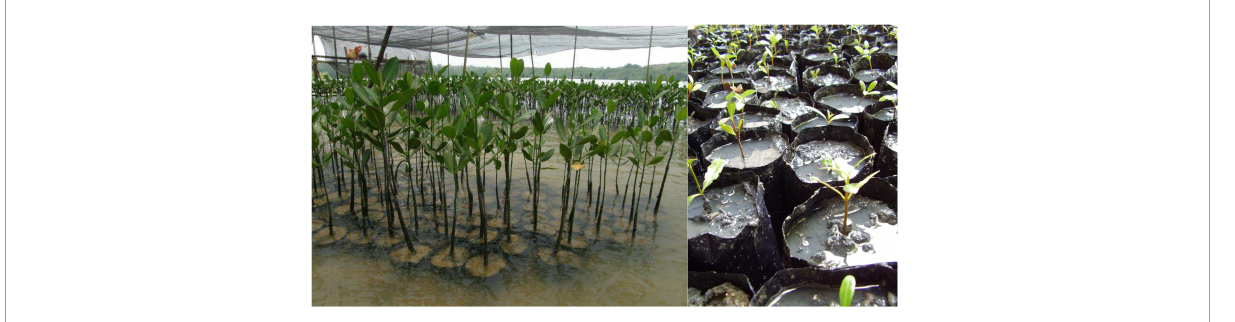
FIGURE2 Ecologically sensitive mangrove plant acclimation strategy. The eco-physiological hardening of Rhizophora stylosa (left) and Avicennia officinalis (right) saplings (inoculated with “old” mud taken from suitable reference sites) by using natural tidal inundation for 1–2 months (Left: 2011, Singapore; Right: 2006, Sri Lanka) (photograph credits: Left: Chua Jit Chern and Jean Yong, Right: Farid